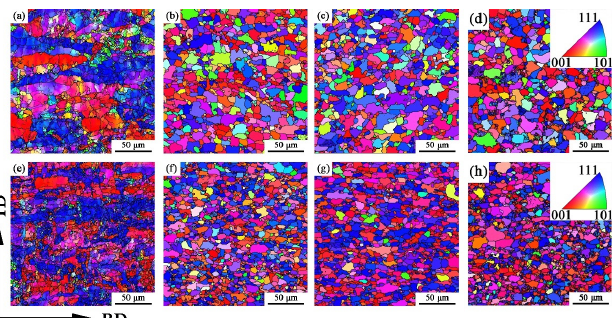
Figure 6. Inverse pole figure (IPF) orientation map projected from the normal of the specimen sur- face at 50% deformation ( a – d ) and 90% deformation ( e – h ) with different annealing temperatures, ( a , e ) deformed; ( b , f ) 720 °C; ( c , g ) 740 °C; ( d , h ) 770 °C. Figure 7 is a schematic of the φ 2 = 45° orientation distribution function (ODF) section that contains the texture components discussed in this work. The main texture compo- nents in the rolled and annealed ferritic stainless steel sheets are distributed on the α and γ orientation lines. All the orientations that belong to the α -fiber have their <110> axes parallel to the RD, where the main texture components on the α orientation line ( φ 1 = 0°, Ф = 0~90°, φ 2 = 45°) are (001)[1 1(cid:3364) 0], (112)[1 1(cid:3364) 0], (223)[1 1(cid:3364) 0], (332)[1 1(cid:3364) 0] and (111)[1 1(cid:3364) 0], etc. In addition, the texture components related to deep drawing properties, e.g., (334)[4 8(cid:3364) 3] and (554)[2 2(cid:3364)5(cid:3364) ], are also easily formed during the annealing process [10].